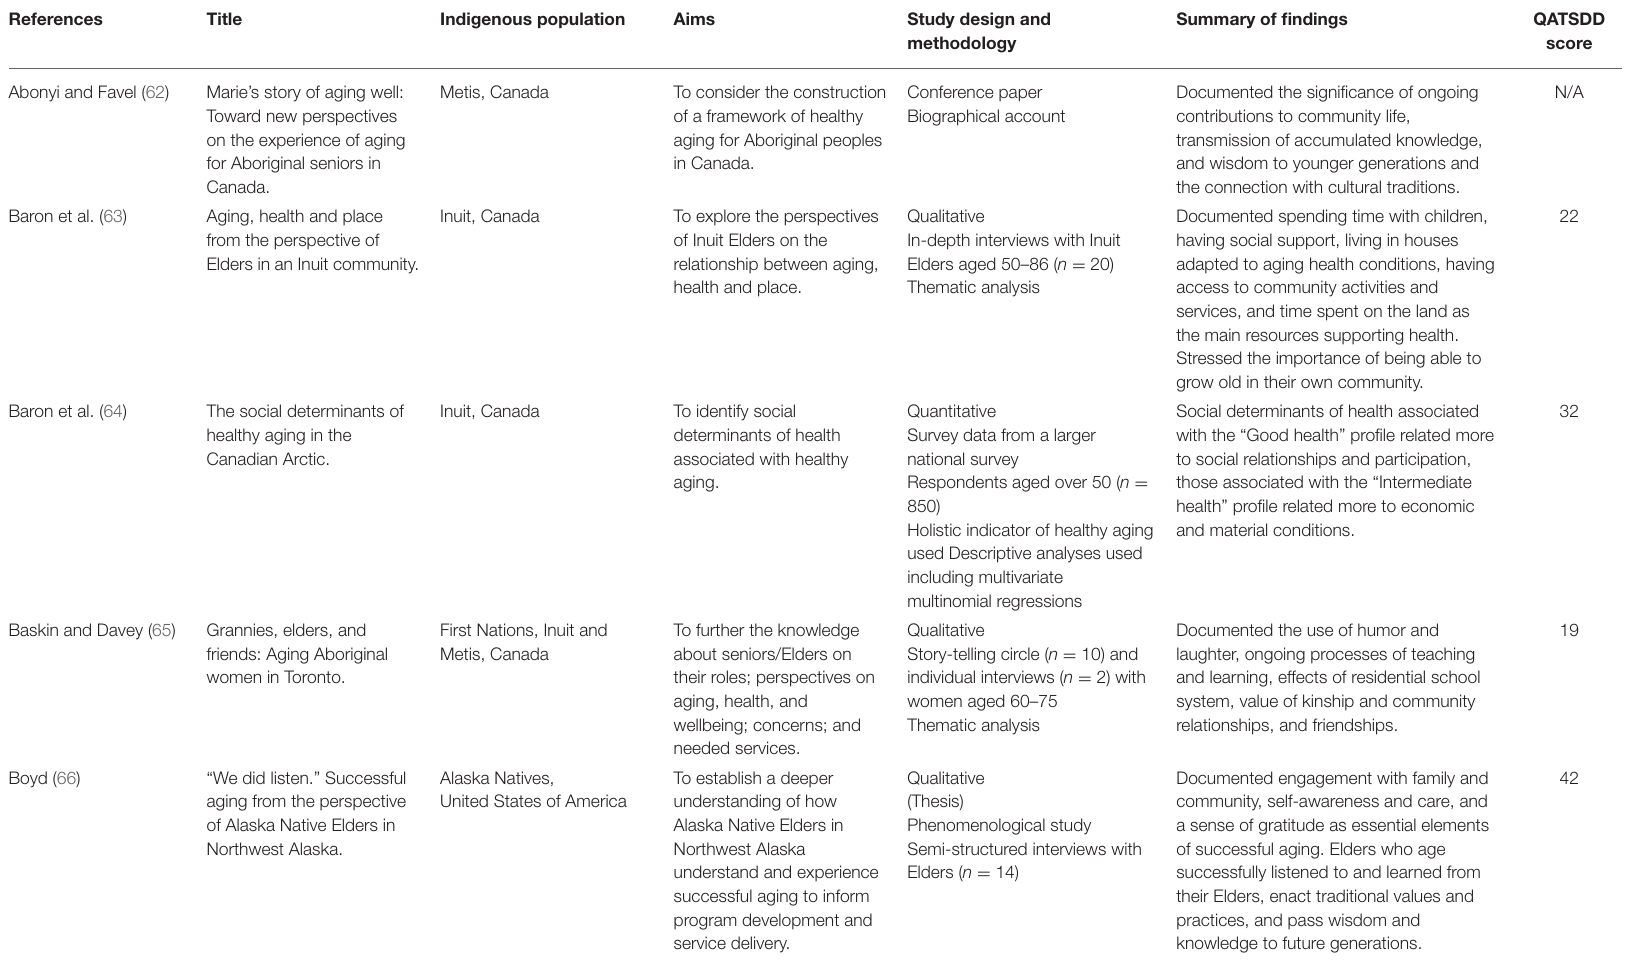
TABLE 2 | Characteristics of included publications ( N =